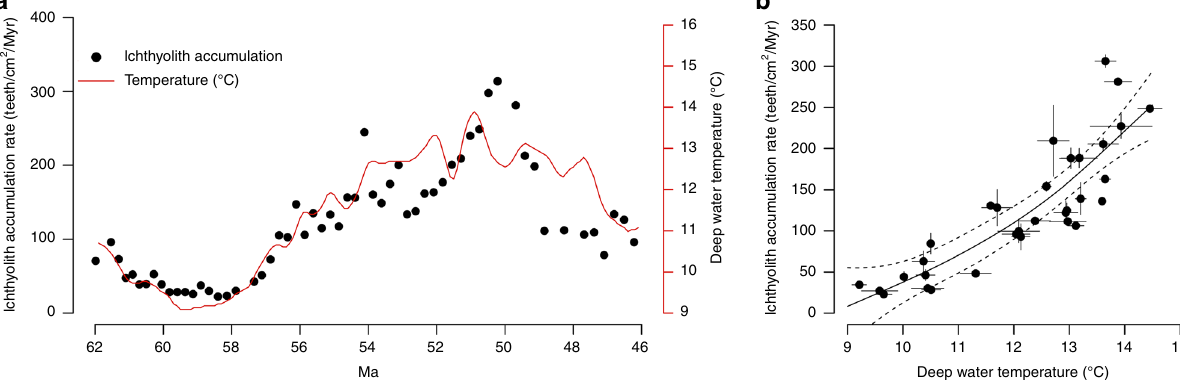
Fig. 1 Correlation between fi sh production and temperature 62 – 46 Ma. a Observed total ichthyolith accumulation rate (black dots) and paleoceanographic temperature reconstruction derived from δ 18 O (red line; ref. 41 ). b Nonlinear regression between total ichthyolith accumulation rate and paleoceanographic temperature, binned by half Myr time intervals. Black dots give the half Myr-binned means for total ichthyolith accumulation rate and temperature, solid lines around the dots give the sample standard deviation. The solid black curve gives the mean regression and dashed black curves give the 95% con fi dence interval for the regression ( n = 32). Source data for ( b ) are provided as a Source Data fi